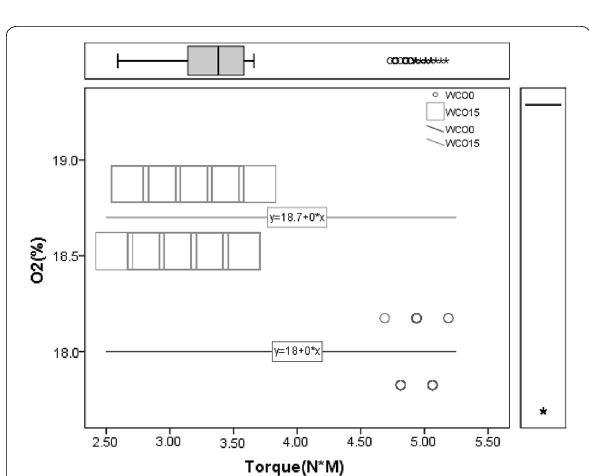
Fig. 11 Scatter plot diagrams for the exhaust characteristics versus torque output [O 2 emission (Unit: %)]